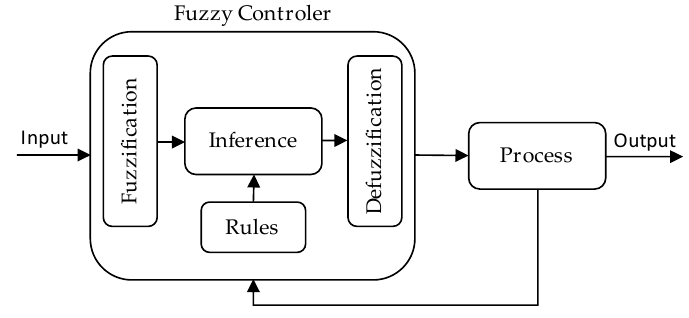
Figure 8. Block diagram for a fuzzy controller.